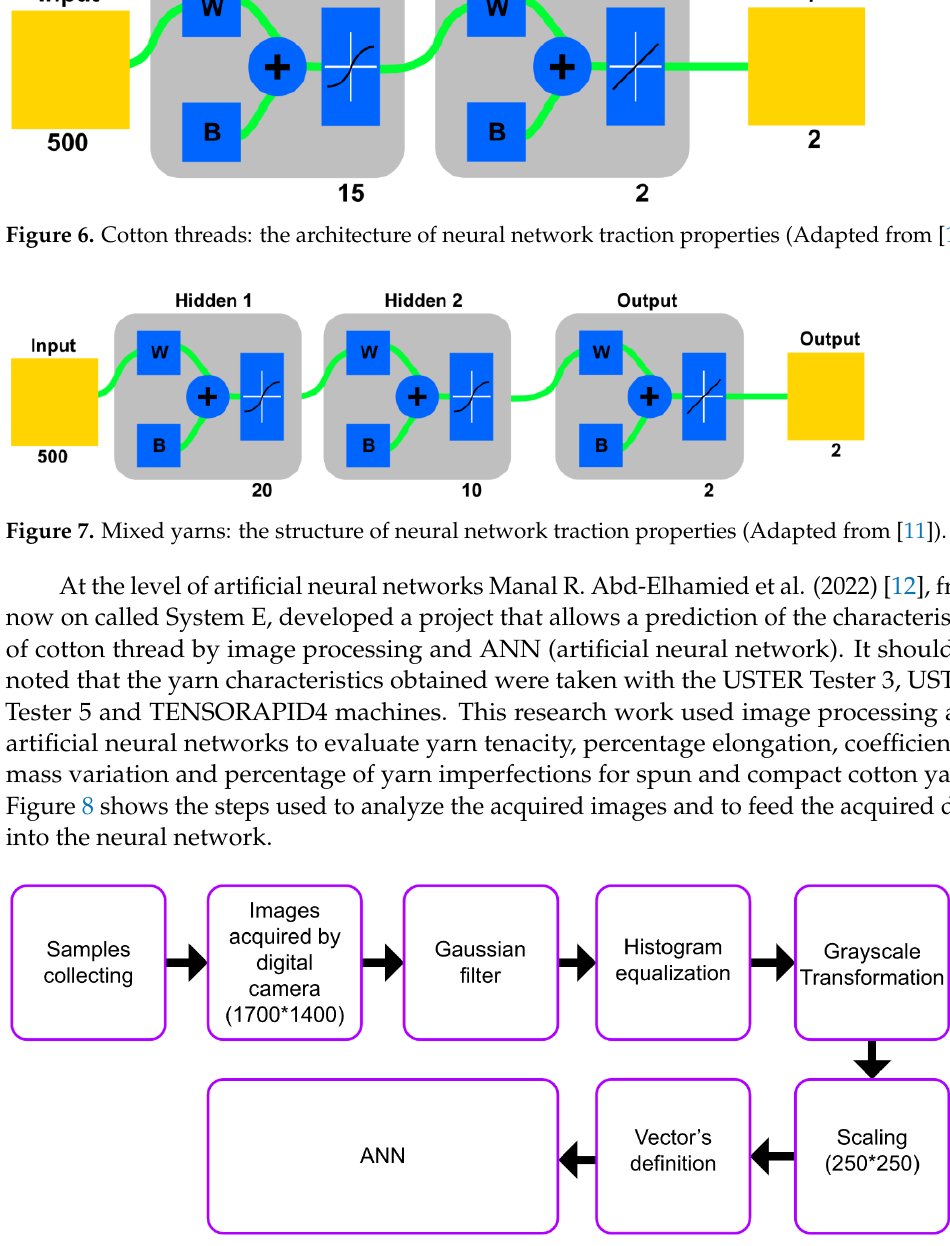
Figure 8. Stages of the process performed (Adapted from [12]).